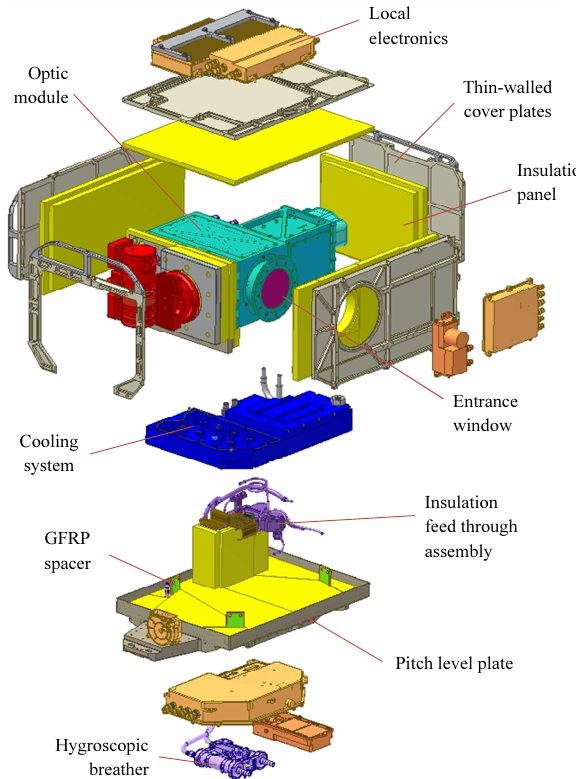
Figure 3. Exploded view of the GLORIA spectrometer showing components of the housing: pitch level plate, cover plates (grey), insulation (yellow), and local electronics (orange). Also shown is the optic module (cyan) with detector (red) and the cooling sys- tem (dark blue). External cables between electronic modules are not